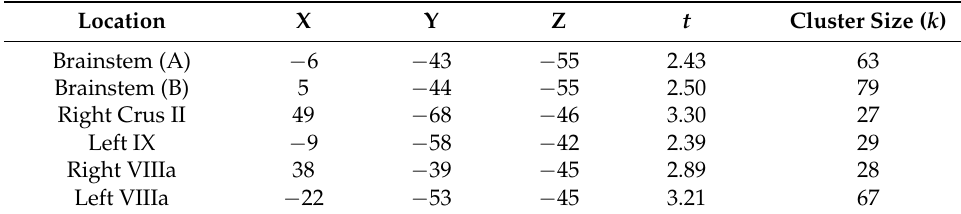
Table 3. MNI coordinates for significant gray matter volume increase following CO-OP intervention in children with DCD.